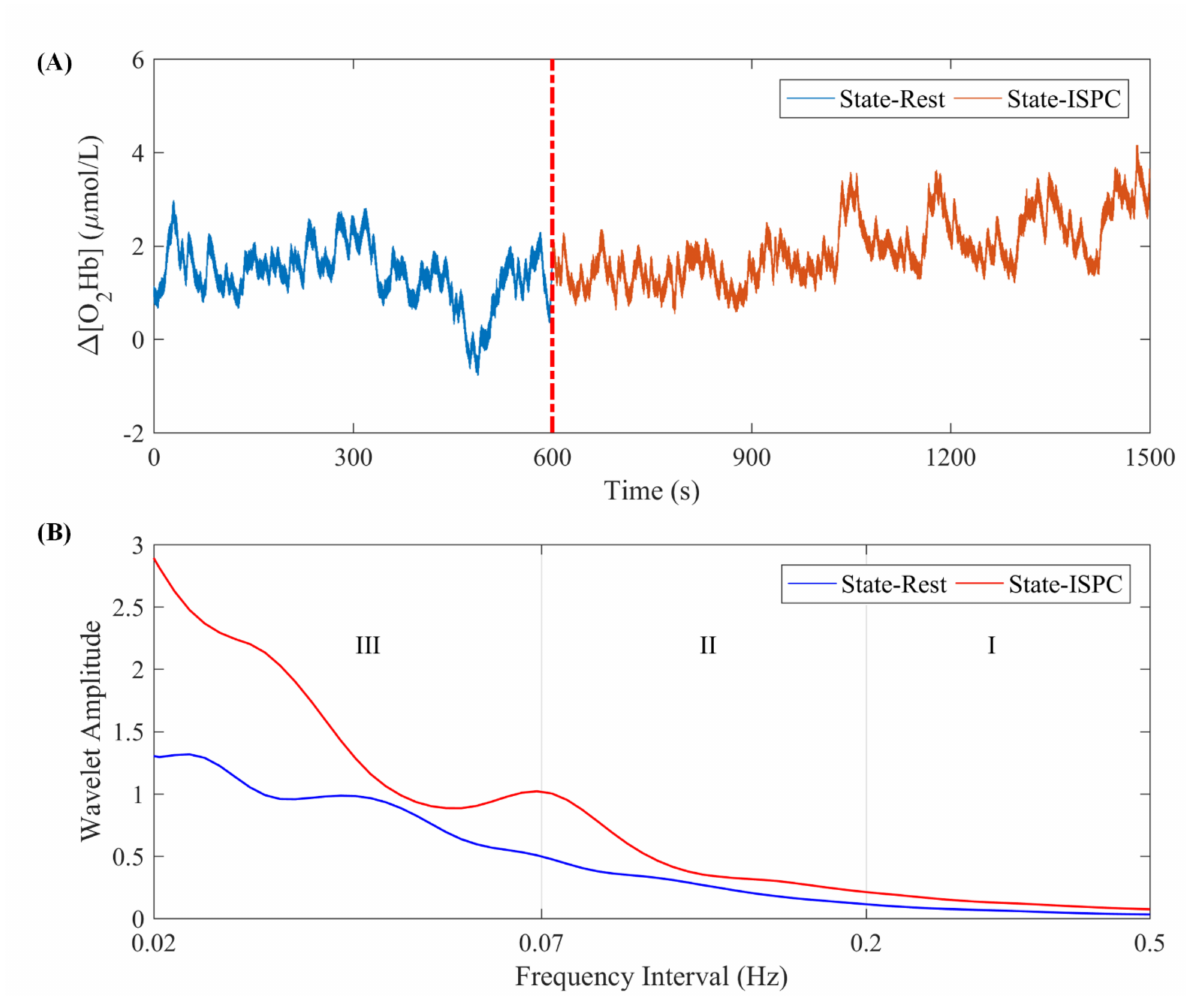
Figure 2. ( A ) Representative time series of the ∆ [O 2 Hb] signal from one subject in State_R and State_ISPC. The red dotted line indicates the start of the ISPC intervention. ( B ) The corresponding wavelet amplitude of ∆ [O 2 Hb] signal. The vertical lines indicate the outer limits of the frequency intervals: I, 0.2–0.5 Hz; II, 0.07–0.2 Hz; and III, 0.02–0.07